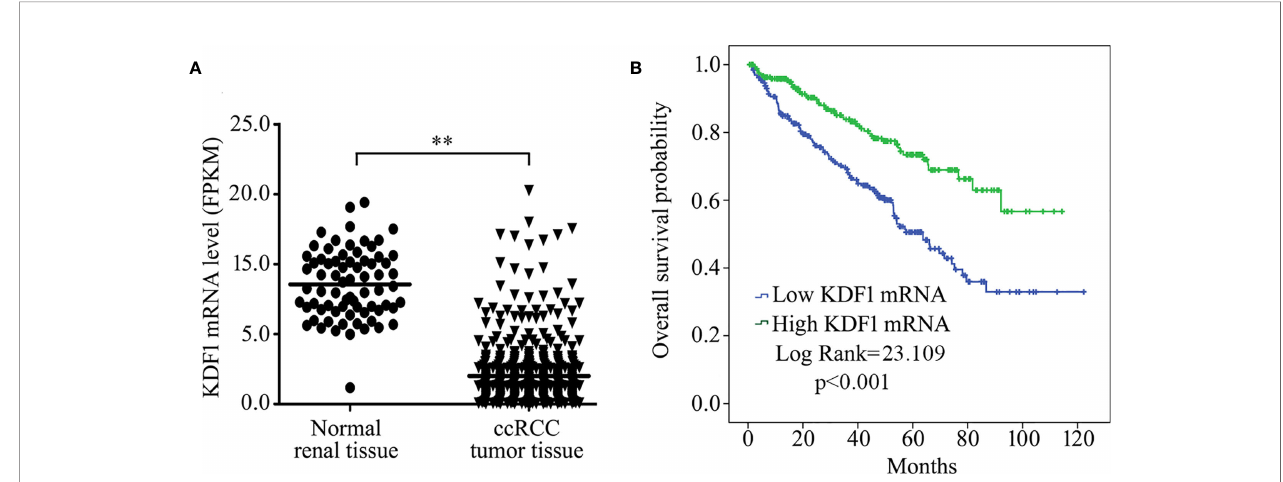
FIGURE 1 | Expression of KDF1 mRNA in the tumor tissue of patients with clear cell renal cell carcinoma (ccRCC) and its association with overall survival. The expression level of KDF1 mRNA in the tumor tissue of 530 ccRCC patients was compared with that in the 72 normal renal samples (A) . Patients were divided into higher KDF1 mRNA subgroup (with the KDF1 mRNA level >1.415 Fragments Per Kilobase per Million (FPKM)) and lower KDF1 mRNA subgroup (with the KDF1 mRNA level ≤ 1.415 FPKM) according to the level of KDF1 mRNA in the tumor tissue and overall survival were compared between the two subgroups by using Kaplan – Meier method (B) . In the analysis of overall survival, 23 patients who died within a month after operation were excluded and a total of 507 patients were included. **p < 0.01. FPKM, Fragments per kilobase